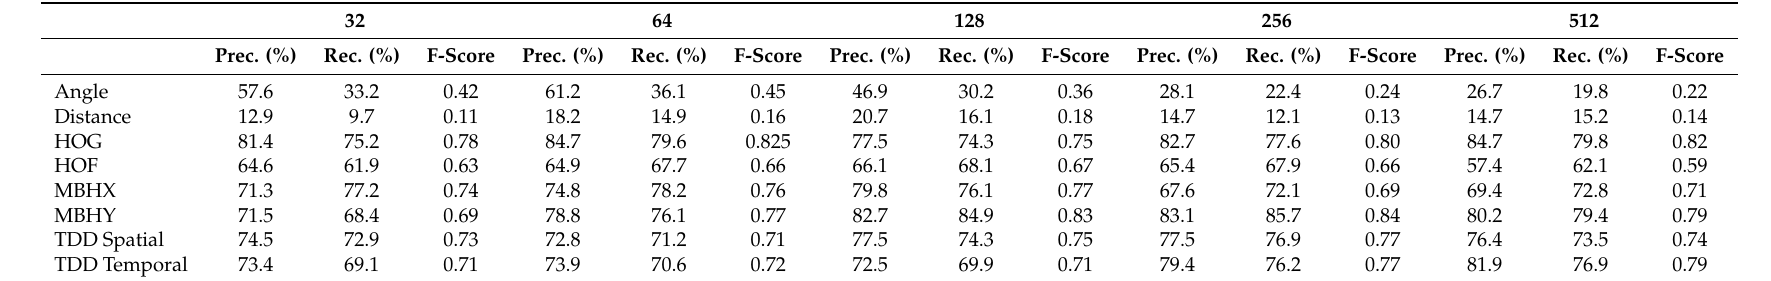
Table 1. Results related to the unsupervised framework with different feature types on GAADRD dataset.